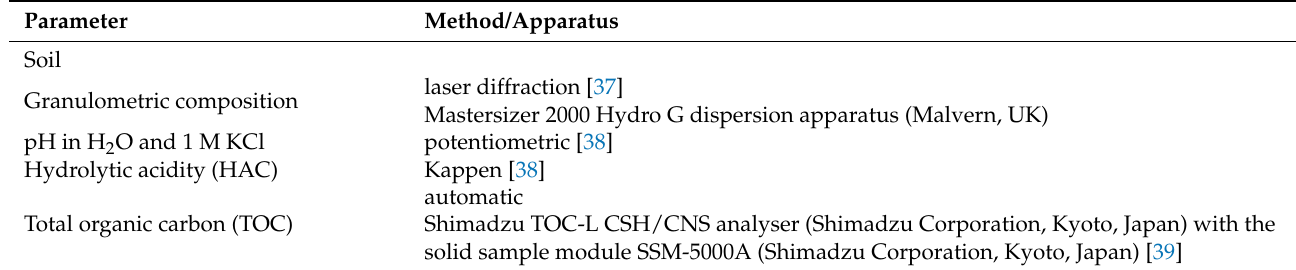
Table 2. Methods of soil and plant